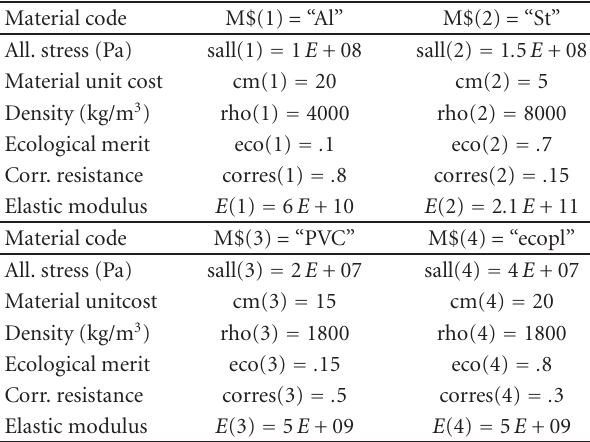
Table 3: Material design variables. sall(im) is allowed stress of ma- terial